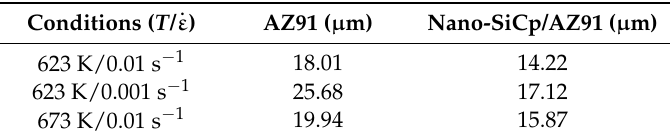
Table 1. Grain sizes of AZ91 alloy and nano-SiCp/AZ91 composite under different conditions. . ε Conditions ( T /